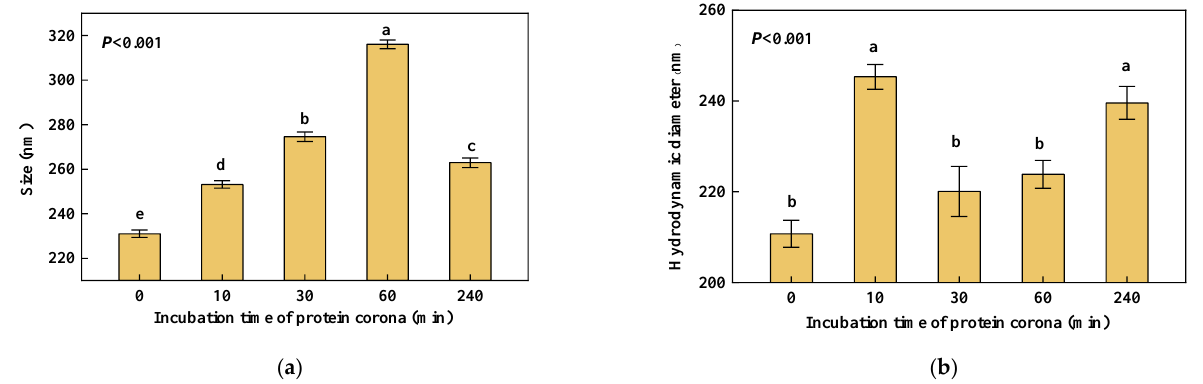
Figure 3. Size ( a ) and hydrodynamic diameter ( b ) changes of PS NPs and the PC over time. Dates are means ± SE ( n = 3~30). Different letters indicate a significant difference at p < 0.05.